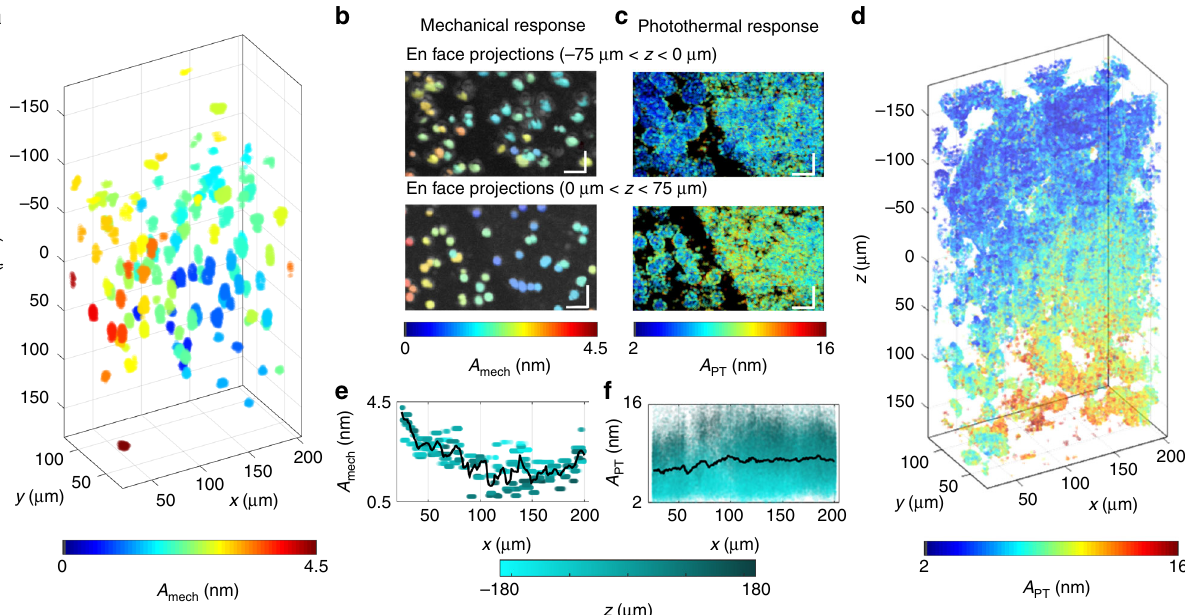
Fig. 6 PF-OCE measurements in the side-by-side sample in the vicinity of the boundary. a A mech ( x b , y b , z b ) in 3D space ( N = 220 beads). b Two en face projections of A mech ( x b , y b , z b ) over a 75 μ m range above and 75 μ m range below the plane z = 0 μ m, overlaid on the OCT image. c Two en face projections of A PT ( x , y , z ) corresponding to 0.1- μ m beads over a 75 μ m range above and 75 μ m range below the plane z = 0 μ m, overlaid on the OCT image. d A PT ( x , y , z ) in 3D space. e , f 2D plot of mechanical and photothermal response against its transverse location e ( A their axial positions. The black line shows the mean of all A mech ( x b , y b , z b ) and A PT ( x , y , z ) at each location on the x -axis. (Scale bars: 20 μ m. See Supplementary Movie 1, which sweeps through responses of en face and cross-sectional projections, in addition to showing the OCT